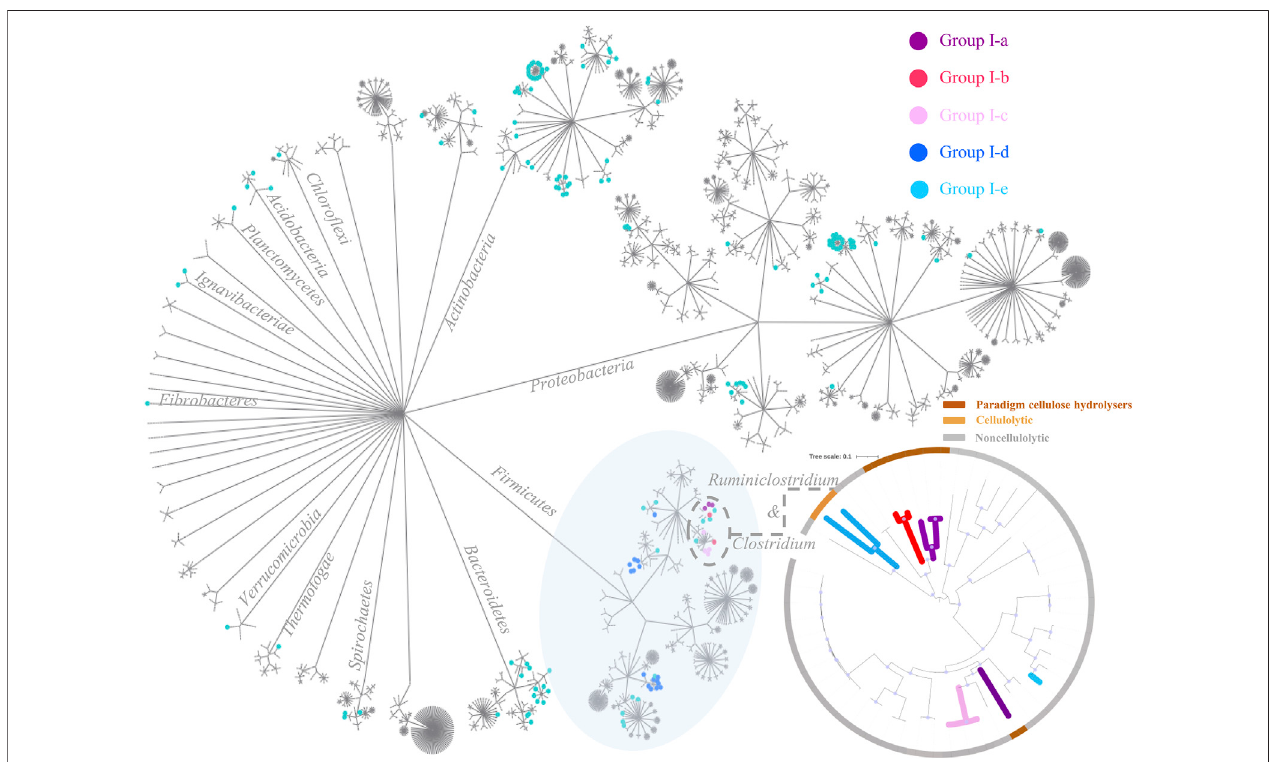
FIGURE 6 | Circle tree of the 2,786 complete genomes. Cellulolytic anaerobes are more likely to be expected in the fi rst fi ve genotype groups (i.e., Group I-a to Group I-e), and nodes of the corresponding strains in these fi ve genotype groups are highlighted in purple, red, pink, blue, and green, respectively. At the lower right corner is a zoomed-in look on microbe strains of Clostridium and Ruminiclostridium , and this small maximum likelihood phylogenetic tree was constructed using FastTree (Price et al., 2010), based on a set of 120 concatenated universal single-copy proteins (Parks et al., 2018), and visualized trough iTOL (Letunic and Bork, 2021);bootstrapvalues > 0.9wereindicatedwithbluedotsalongbranches.Theinnerbranchesofthissmallertreearehighlightedaccordingtothegenotypegroupeach strainwasassignedto,andtheouterrangeswerecoloredaccordingtowhetherthecorrespondingstrainiscellulolyticornot,thatis,brown-paradigmcellulolytic,yellow- cellulolytic, and grey-noncellulolytic